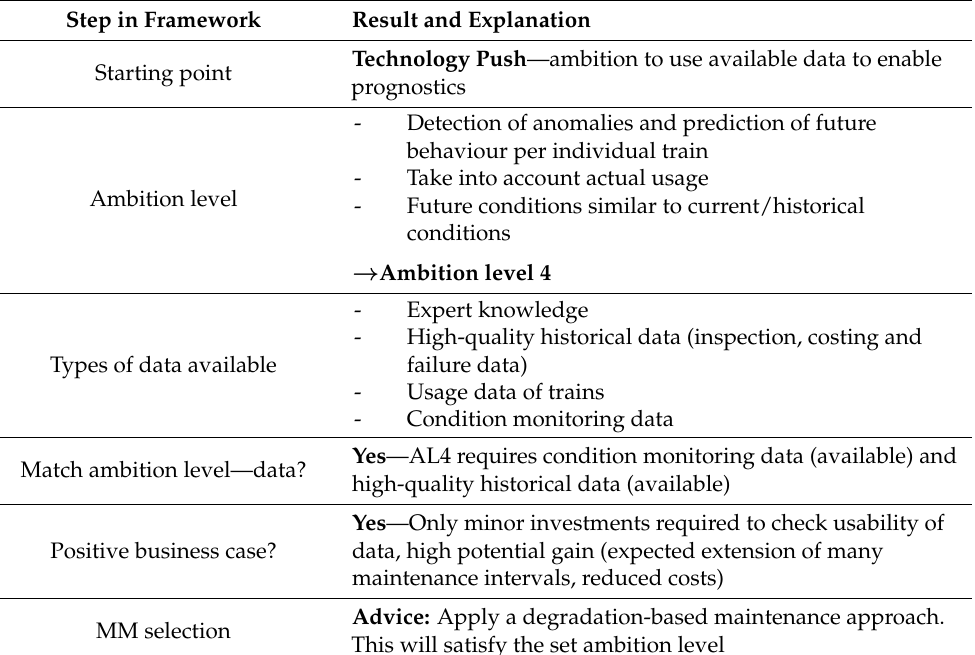
Table 6. Application of the decision framework to case